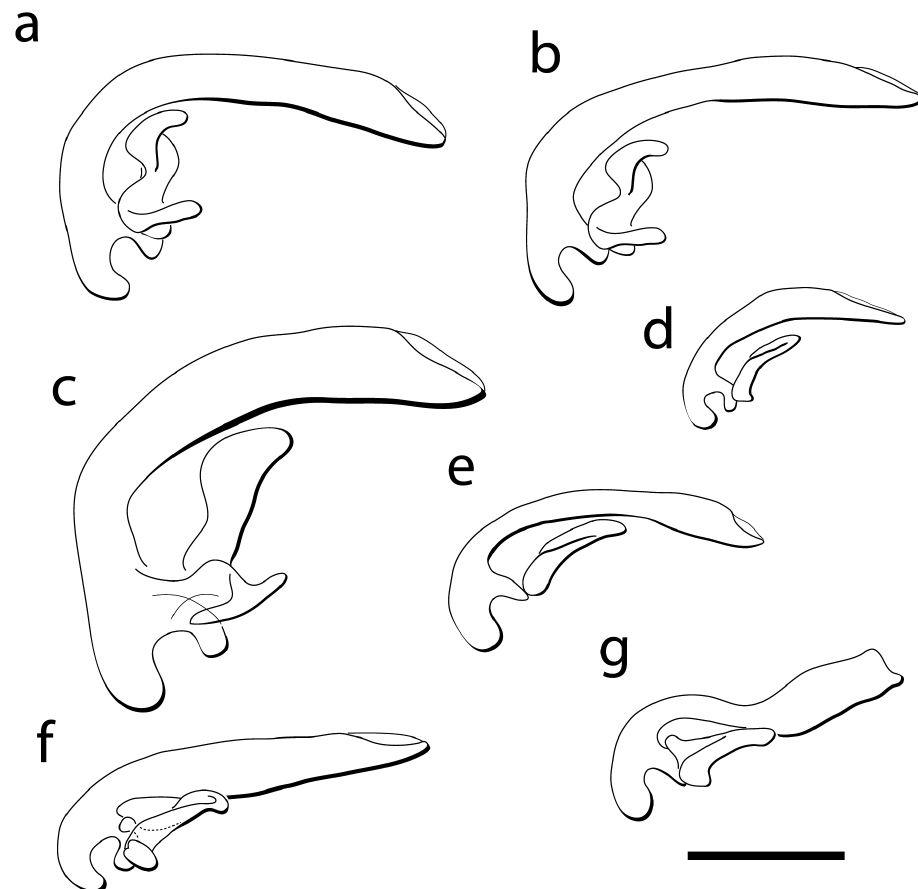
Figure 11. Male genitalia, left lateral view of the median lobe and left paramere for: a Cratocerus sine- setosus b Cratocerus multisetosus c Cratocerus monilicornis ; d Cratocerus tanyae e Cratocerus indupalmensis